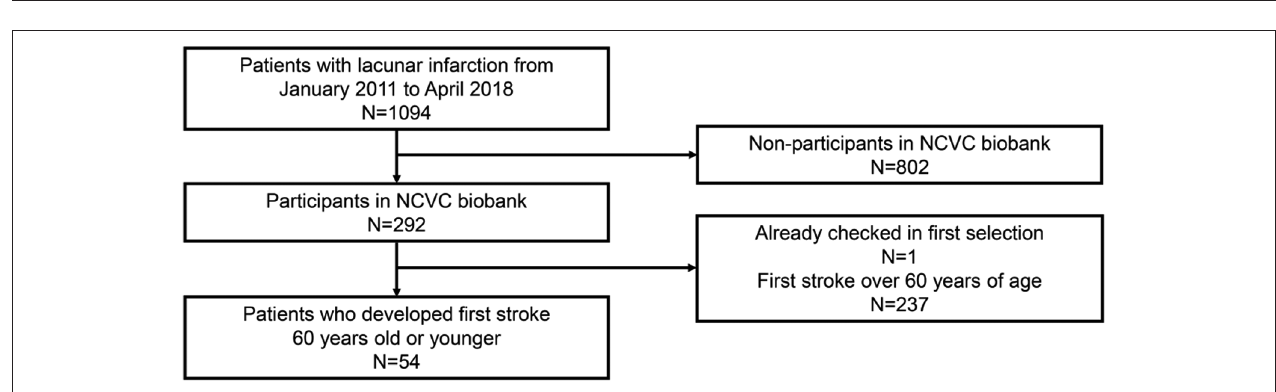
FIGURE 1 | Patient selection flow diagram for the phase 1 cohort. NCVC, National Cerebral and Cardiovascular Center; CADASIL, Cerebral autosomal dominant arteriopathy with subcortical infarcts and leukoencephalopathy; DWMH, deep white matter hyperintensity; PVH, periventricular hyperintensity.